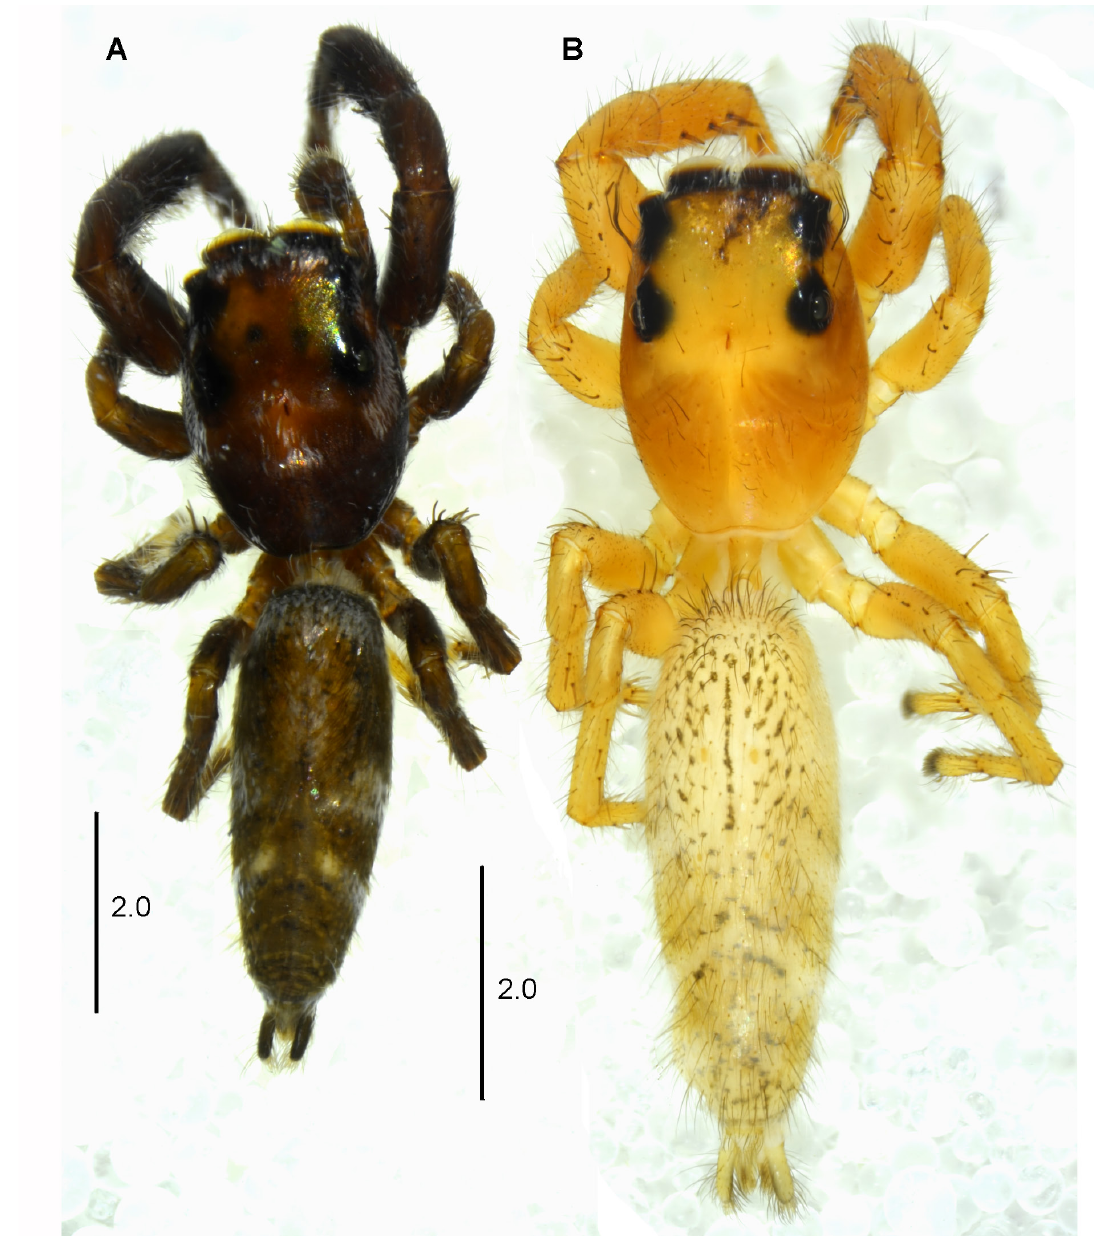
Fig. 71. Thyene hesperia (Simon 1909), ♂♀ (MNHN). A . Habitus of male, dorsal view. B . Habitus of female, dorsal